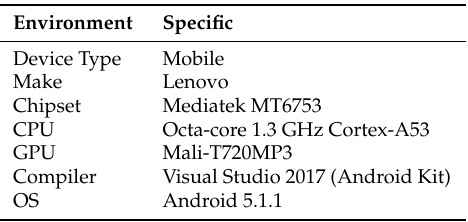
Table 13. Proposed protocol environment for evaluation over a mobile device.